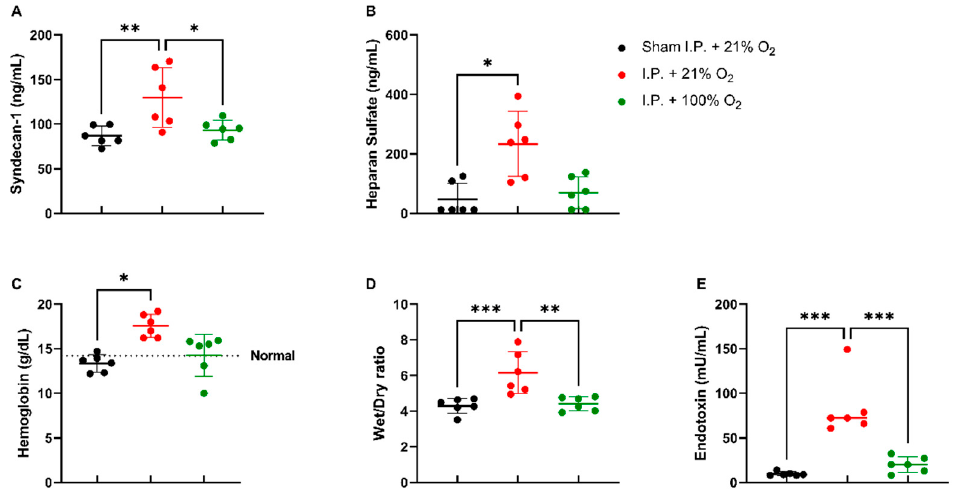
Figure 3. Vascular barrier changes due to oxygen supplementation were assessed by measuring plasmatic endothelial glycocalyx components: syndecan-1 ( A ) and heparan sulfate ( B ). Secondary effects in the form of hemoglobin concentration ( C ), reperfusion edema (wet/dry ratio, ( D )), and bacterial translocation (plasmatic endotoxin levels, ( E )) were measured ( n = 6/group). I.P.: intraperitoneal injection anesthesia; O 2 : oxygen. Normal value is shown by a horizontal dashed line in graph ( C ). * p < 0.05; ** p < 0.01; *** p <